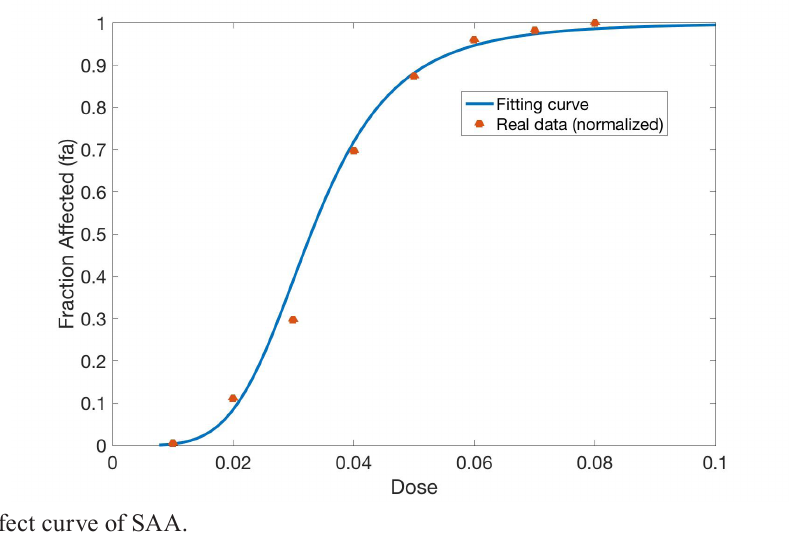
FIGURE 2 - The dose-effect curve of SAA.